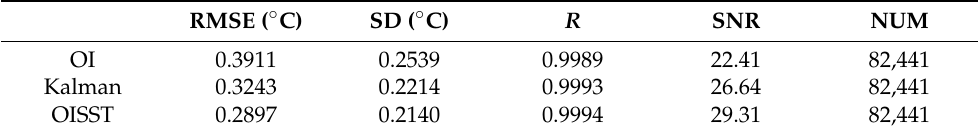
Figure 10. Time series of ( a ) root-mean-square error (RMSE), ( b ) standard deviation (SD), ( c ) correlation coefficient (R), and ( d ) signal-to-noise ratio (SNR) from OI, Kalman and OISST results for 2016. Table 1. Error statistics for OI, Kalman and OISST results for 2016.